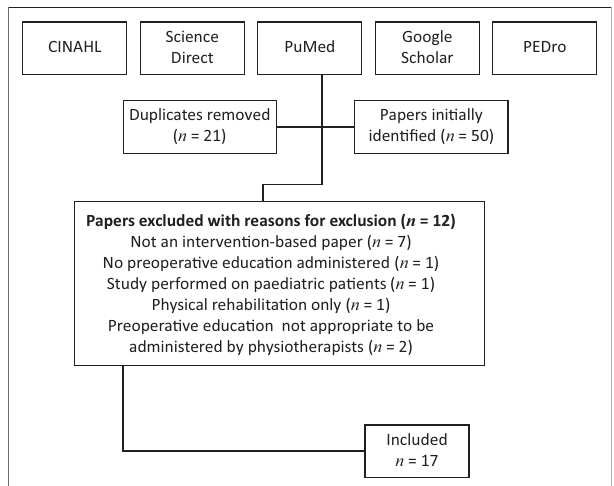
FIGURE 1: Flow diagram of article